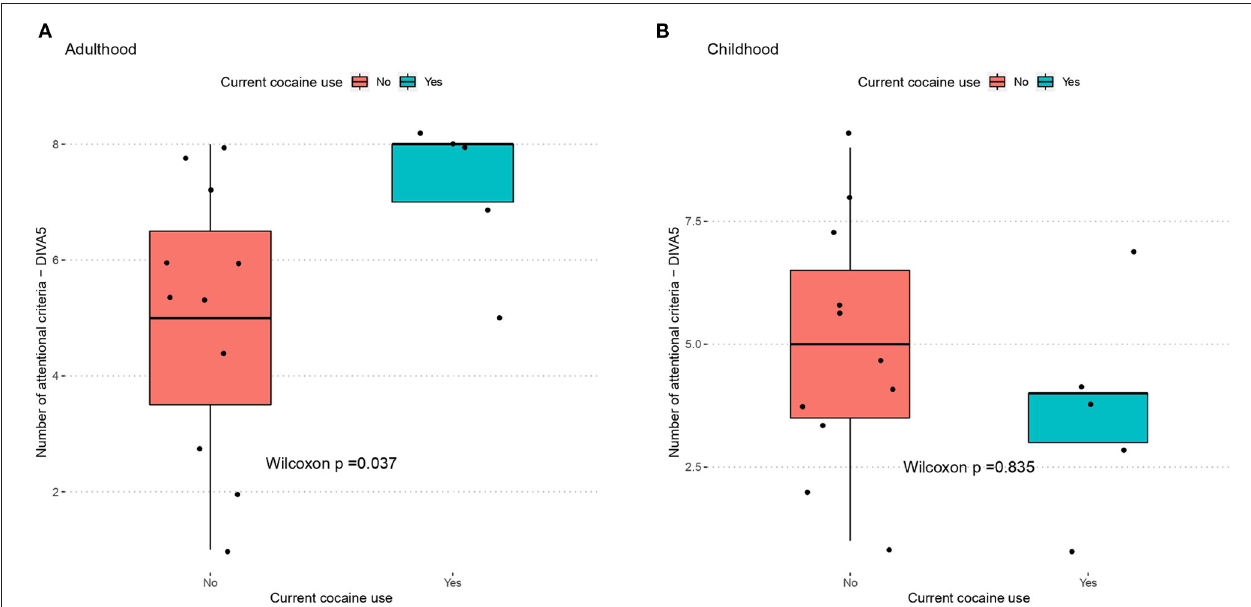
FIGURE 2 | Cocaine use as a function of inattentive symptoms during (A) adulthood and (B) childhood. ADHD measured by the DIVA-5, cocaine use measured by anamnestic interview. BEARNI, Brief Evaluation for Alcohol Related Neuropsychological Impairment; FAB, Frontal Assessment Battery; DIVA, Diagnostic Interview for ADHD in Adult.